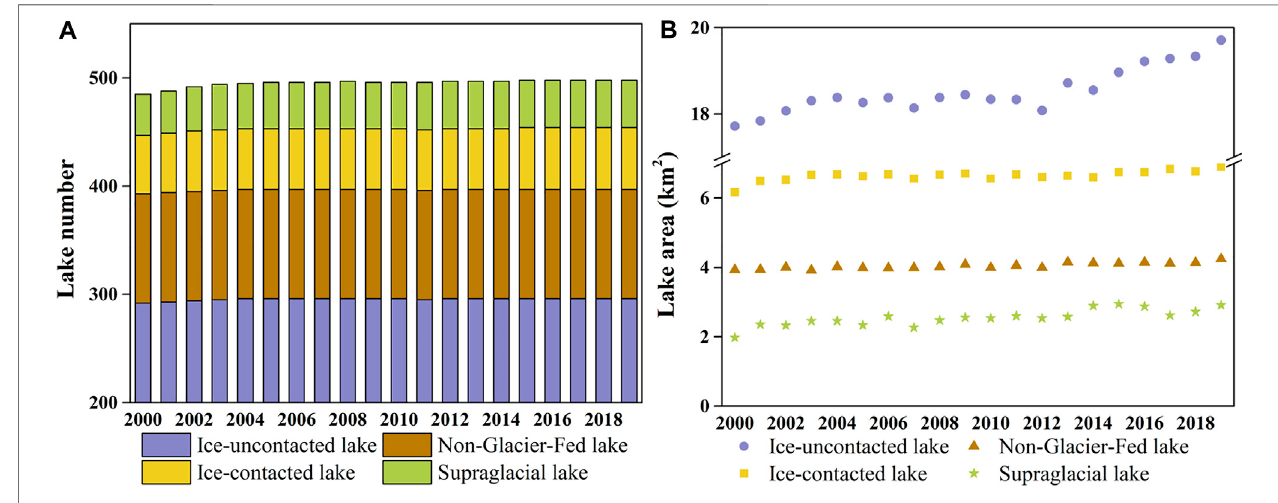
FIGURE 7 | Number (A) and area (B) change of four types glacial lakes.